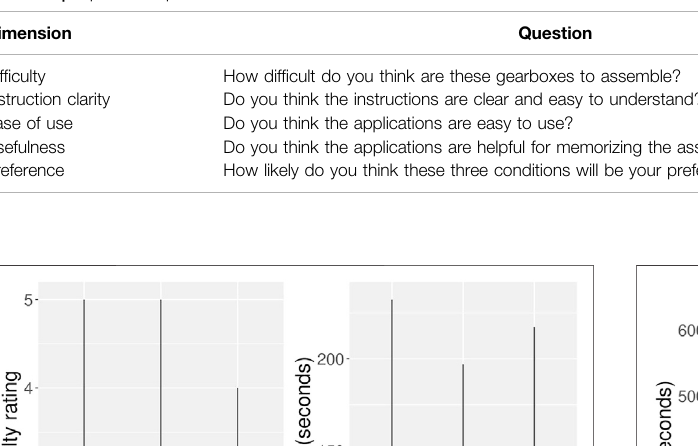
TABLE 3 | Experience questionnaire.